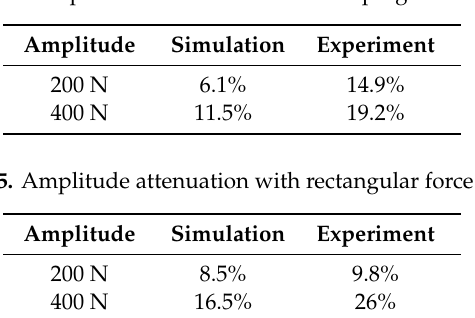
Table 4. Amplitude attenuation with damping force load.